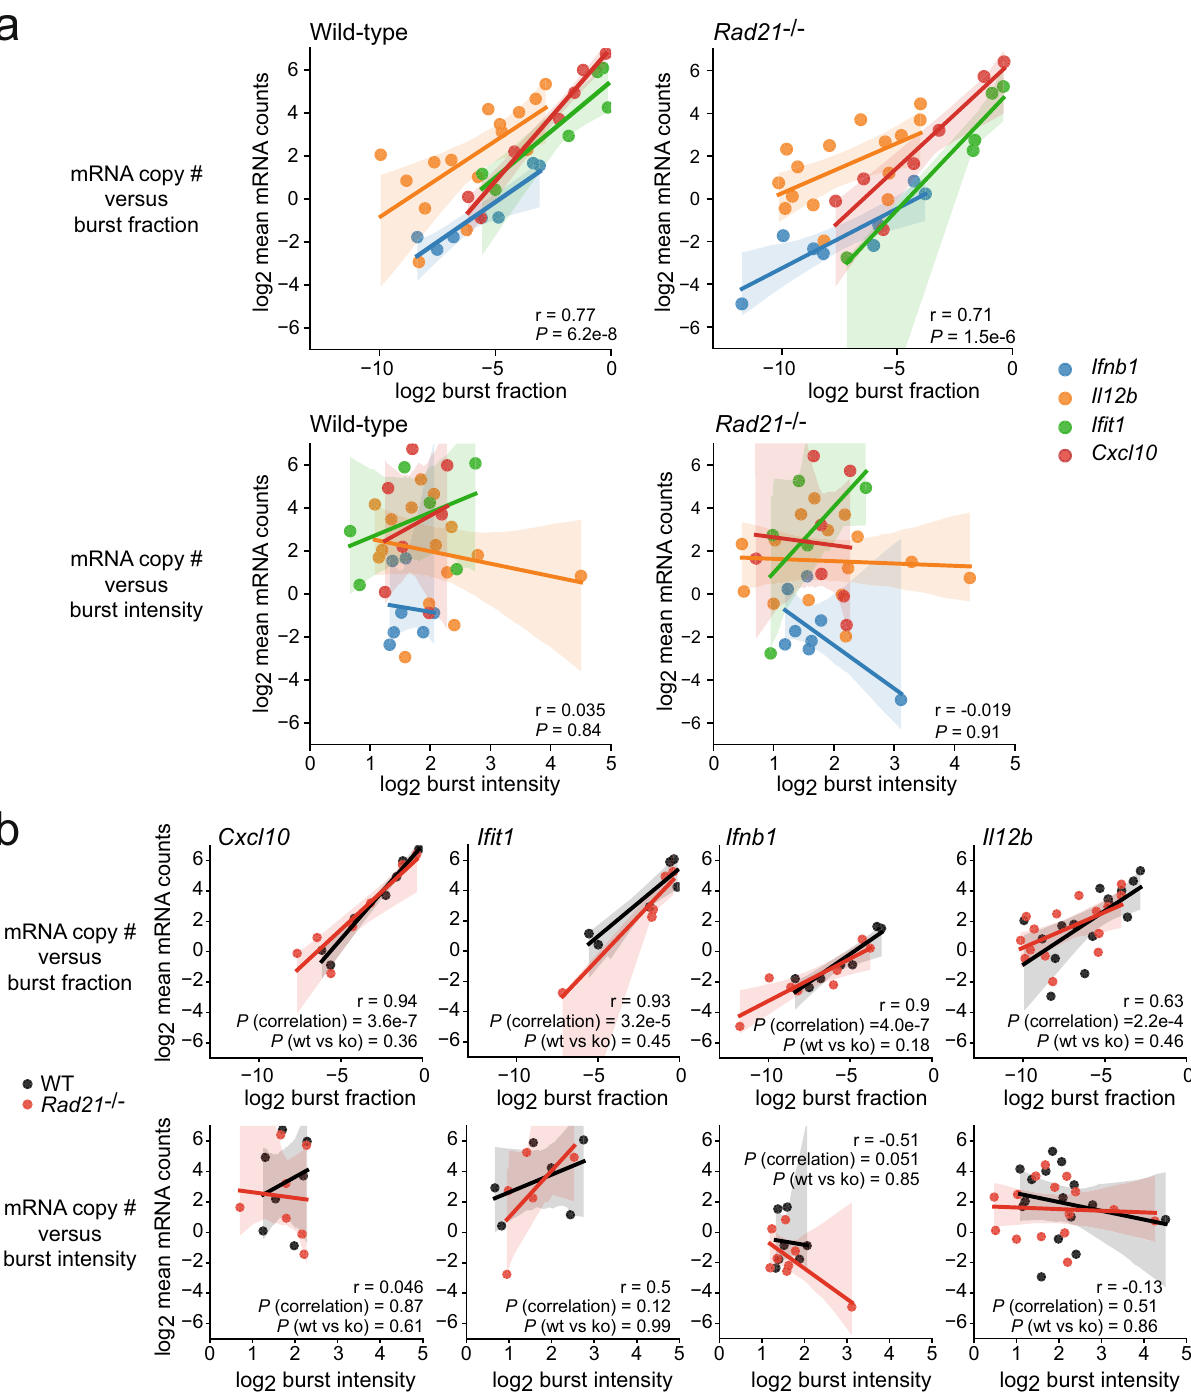
Fig. 6 Transcriptional bursting is productive in the absence of cohesin. a Transcript copy number correlates with transcriptional burst fraction in the absence of cohesin. Transcript copy number, a burst fraction (top) and burst intensity (bottom) were determined for wild-type (left) and Rad21 − / − macrophages (right) as determined by smRNA-FISH using intronic probes for Il12b and exon probes for I fi t1, Cxcl10 , and Ifnb1 . Shown are individual replicates for each gene in wild-type and Rad21 − / − macrophages after 0, 30, 60, 90, 120 or 180 min of LPS stimulation. The overall correlation was tested. r Pearson correlation, error bands: 95% con fi dence interval. Two-sided Pearson's product-moment correlation (null hypothesis: correlation = 0). N = 78,747 cells, 3 – 4 independent biological replicates per transcript. b Transcript copy number, a burst fraction (BF, top) and burst intensity (BI, bottom) for wild-type (black) and Rad21 − / − macrophages (red) as in Fig. 4d. For each gene we tested the overall r: Pearson correlation, error bands: 95% con fi dence interval. Two-sided Pearson's product-moment correlation against the null hypothesis: correlation = 0). Statistical test for differences between wild-type and Rad21 − / − macrophages: two-way ANOVA in R with interaction formula l log 2 .mean.mRNA.counts ∼ log 2 . Burst fraction * Genotype + log 2 . Burst intensity * Genotype. N = 78,747 cells, 3 – 4 independent biological replicates per transcript.